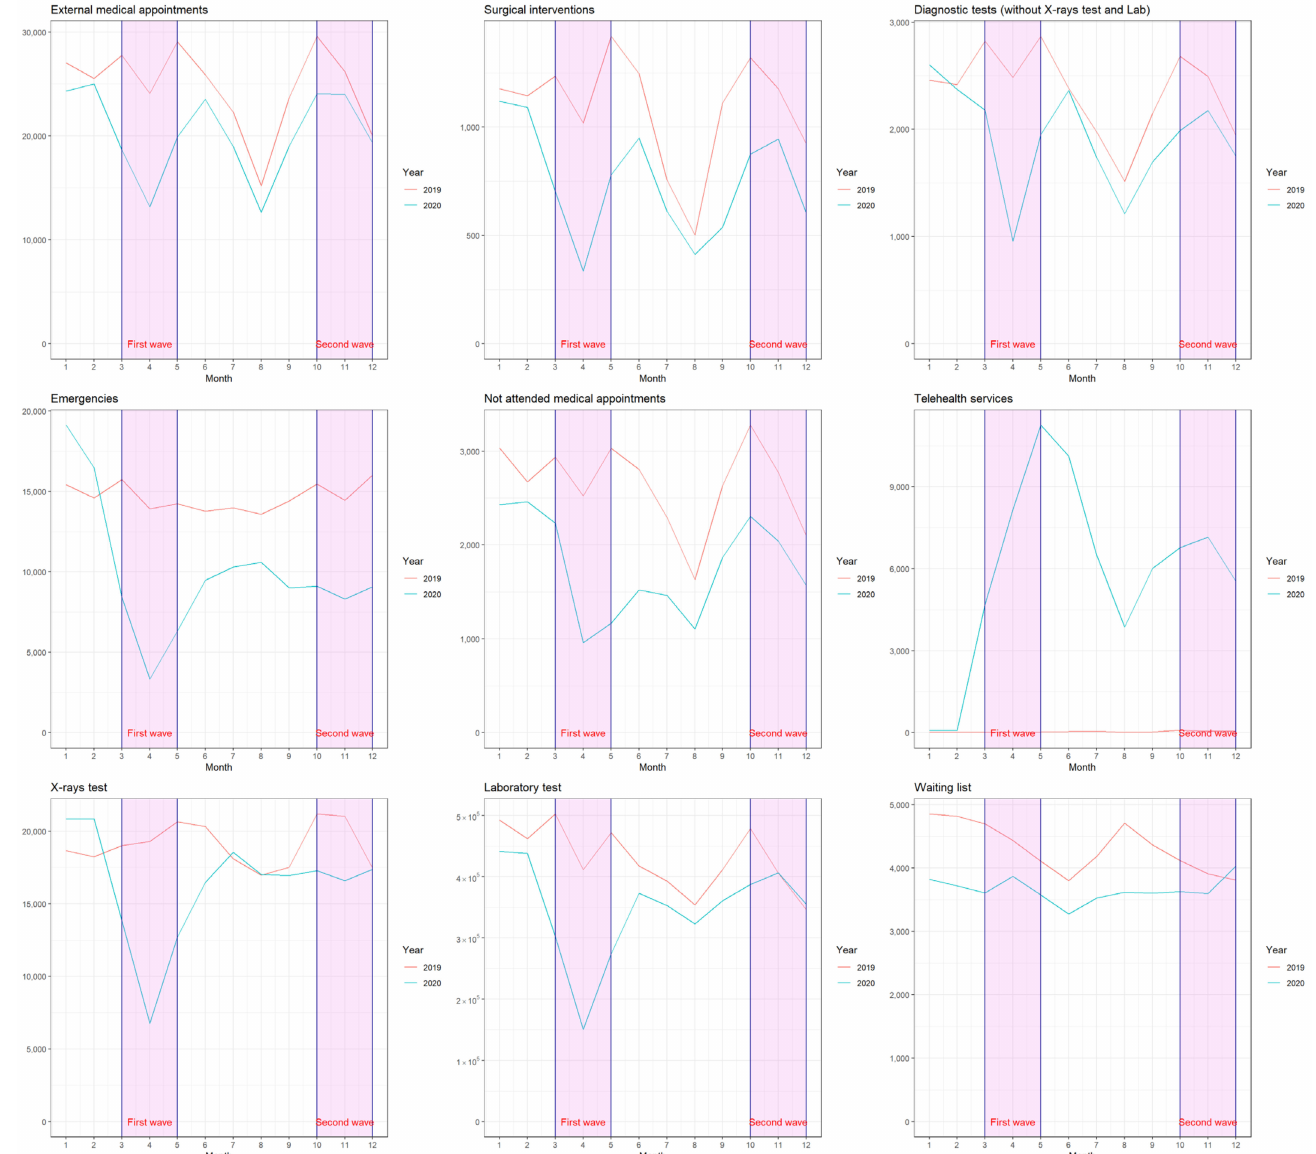
Figure 2. Monthly evolution for the years 2019 and 2020 at the Poniente Hospital. The first wave and lockdown of Covid-19 in Spain took place between March and May 2020, while the second wave and semi lockdown was between October and December